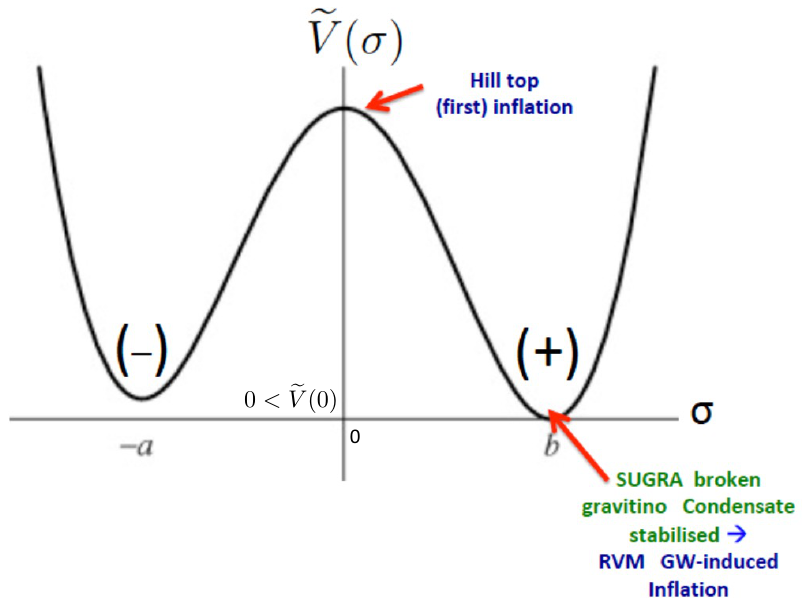
V ( σ ) vs. the condensate field σ , for dy- Figure 1. The double-well gravitino-condensate potential namical supergravity breaking [63,64,129,130], in which there is an effective lift of the degeneracy (cid:101) of the two vacua due to percolation effects in the early universe that lead to different occupation probabilities for the two ground states [131,132]. The reader should notice that the values of the potential at these ground states are both positive, consistent with the dynamical breaking of super- gravity [129,130]. This bias between the two vacua leads to the formation of unstable domain walls, whose non-spherical collapse, or collisions produce Gravitational Waves (GW). The lowest of these two vacua indicates dynamical breaking of supergravity, with a stabilised gravitino condensate, which also implies GW-induced RVM inflation. The model may have a hill-top first inflation, near the origin of the gravitino condensate field σ (cid:39) 0, as indicated, which ensures that any spatial inhomo- geneities are washed out well before the entrance of the universe intro the RVM inflationary phase, induced by GW condensation. Figure taken from